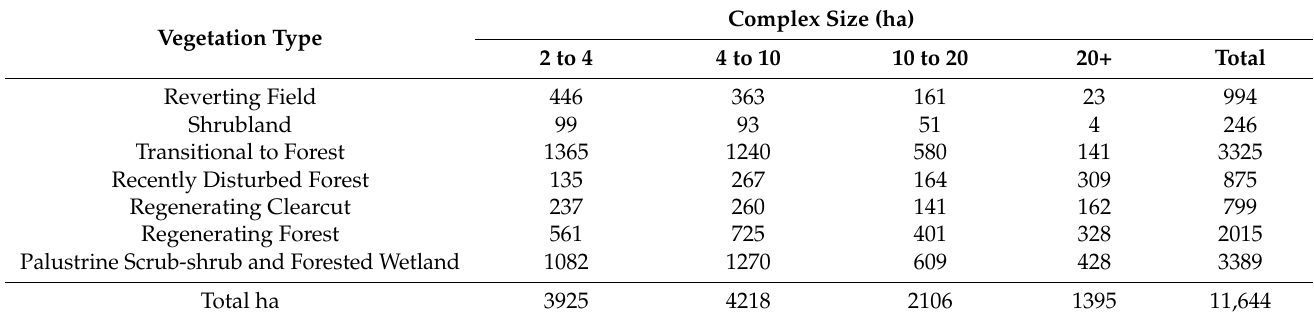
Table 8. Hectares of young forest and shrubland vegetation types by complex size for the American woodcock Focus